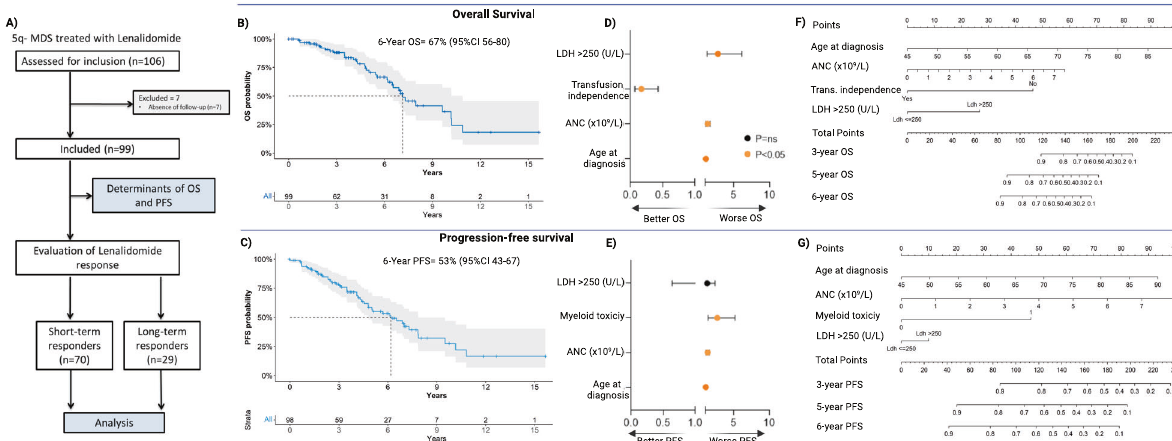
Fig. 1 Study design and patients ’ outcomes. A CONSORT diagram showcases the study design and patient enrollment. B A Kaplan-Meier curve shows overall survival (OS) de fi ned as the time from diagnosis of MDS to death for any cause. Censoring was applied to cases alive at the last follow-up. With a median follow-up time of 5.6 years (1.9 – 6.9), the 6-year OS was 67% (56 – 80). Numbers at risk are indicated below the curve. C A Kaplan-Meier curve shows progression-free survival (PFS) de fi ned as the time from diagnosis to disease progression or death from MDS. Censoring was applied to cases alive at last follow-up. The 6-year PFS was 53% (43 – 67). Numbers at risk are indicated below the curve. D , E , Forrest plots illustrate the results of multivariate analysis for OS and PFS, respectively, using a multivariate cause-speci fi c Cox model. Nomograms for OS and PFS are shown in F and G , respectively. Brie fl y, each predictor with a given value can be mapped to the Points axis. The sum of these points can be referred to in the Total Points axis. The linear predictor and the probability of survival outcome at 3-, 5-, and 6-year can be obtained from the corresponding